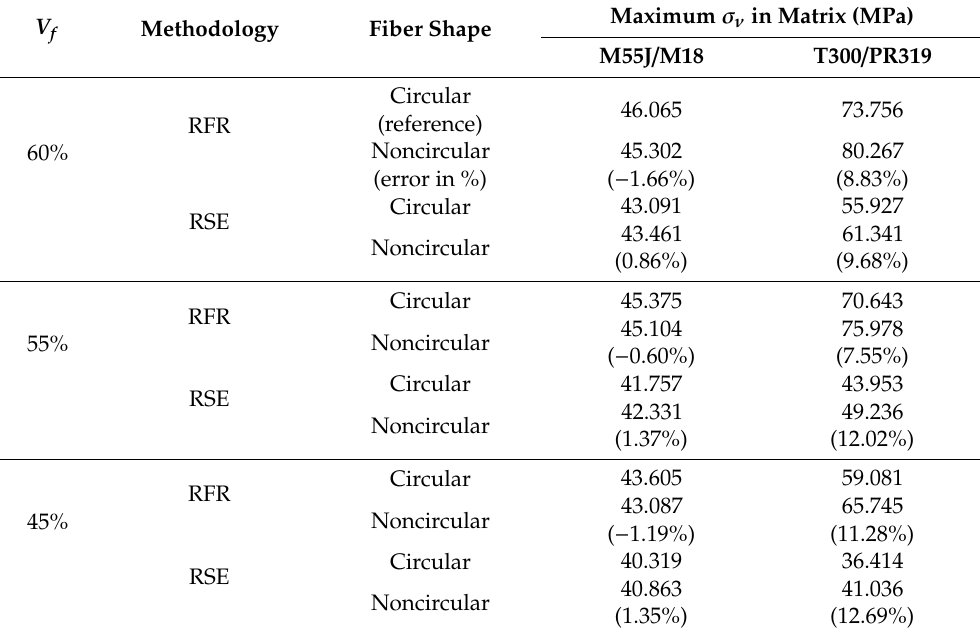
Table 7. Comparison of the maximum von Mises stress in